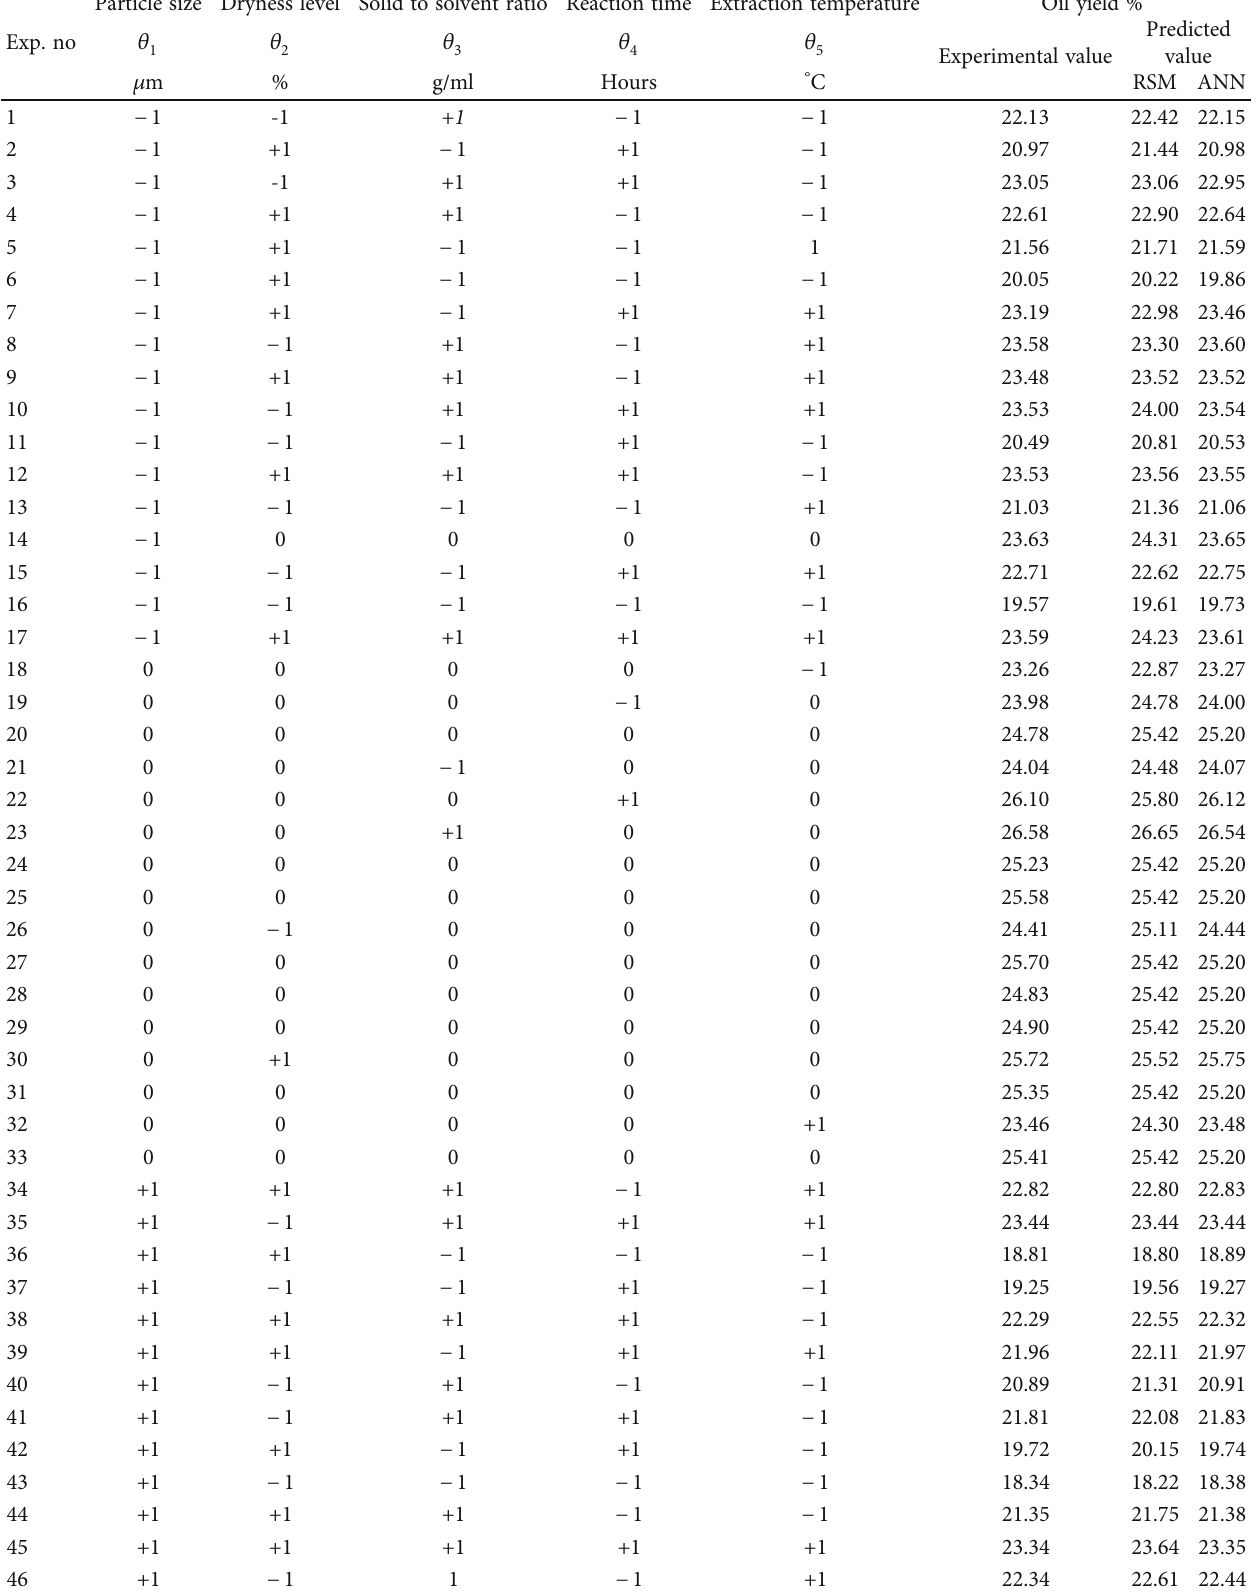
Table 2: The CCD arrived with Design-Expert factorial design and the response